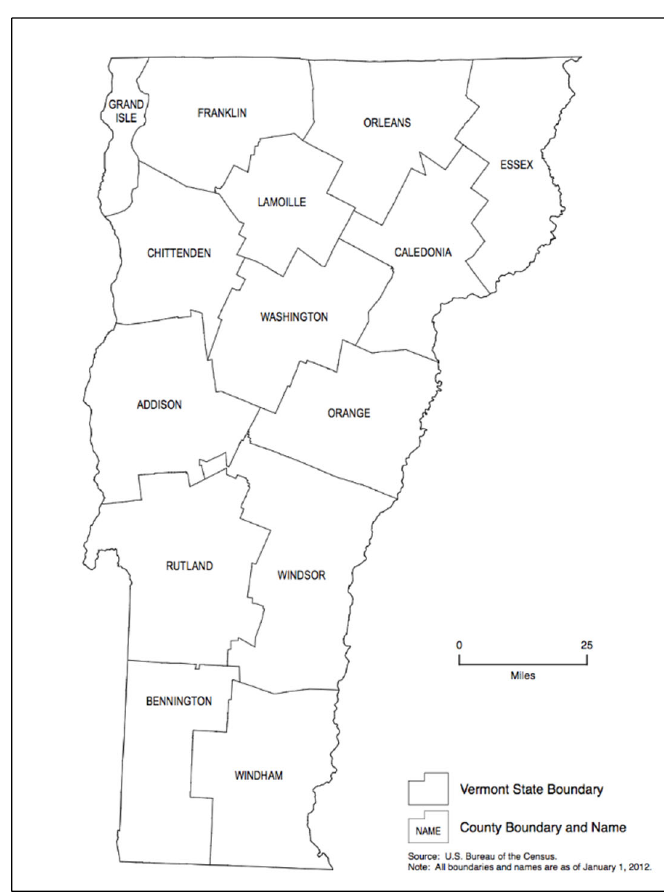
Figure 1. Vermont